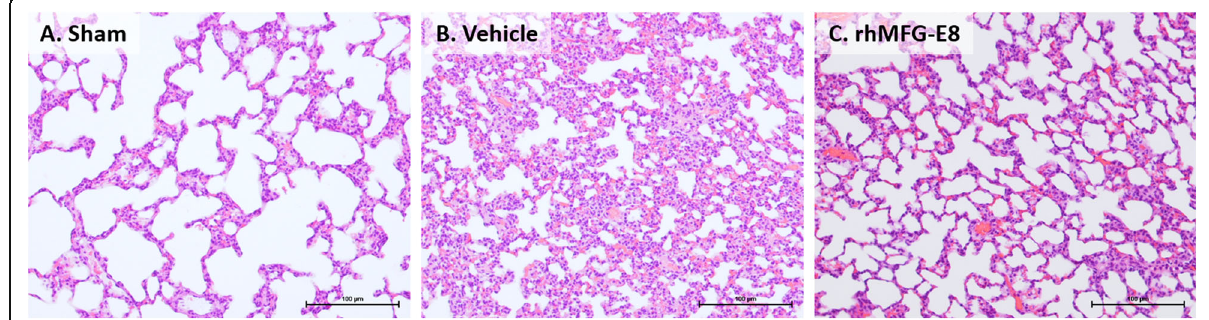
Fig. 4 rhMFG-E8 ameliorates acute lung injury in CLP after acute alcohol exposure. While the lungs of ( a ) sham rats displayed a normal histological architecture, those of ( b ) CLP rats treated with vehicle had alveolar septal thickening with neutrophil infiltration and hyaline deposits. The lungs of ( c ) CLP rats treated with rhMFG-E8, however, had less severe histological lung injury. Representative images of tissue sections with H&E staining: original magnification: 200×. Prior to CLP, all rats were exposed to acute alcohol intoxication; n = 10 – 14 for sham and n = 9 for